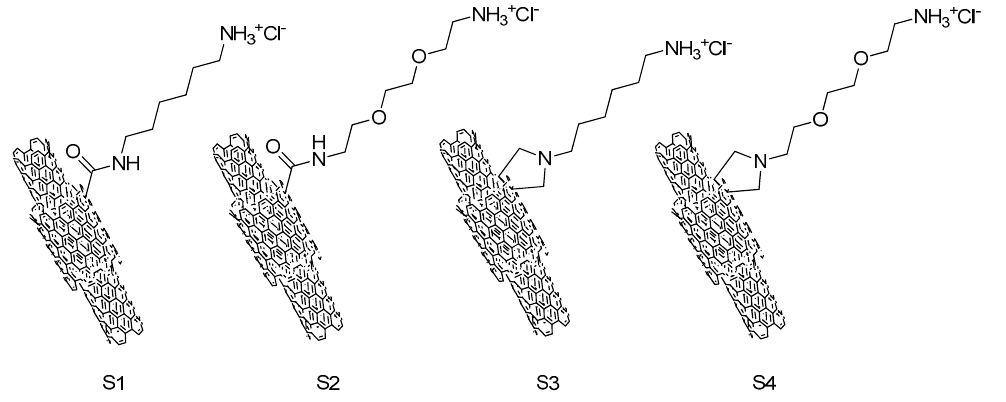
Figure 1. Molecular structures of ammonium-functionalized MWCNTs.